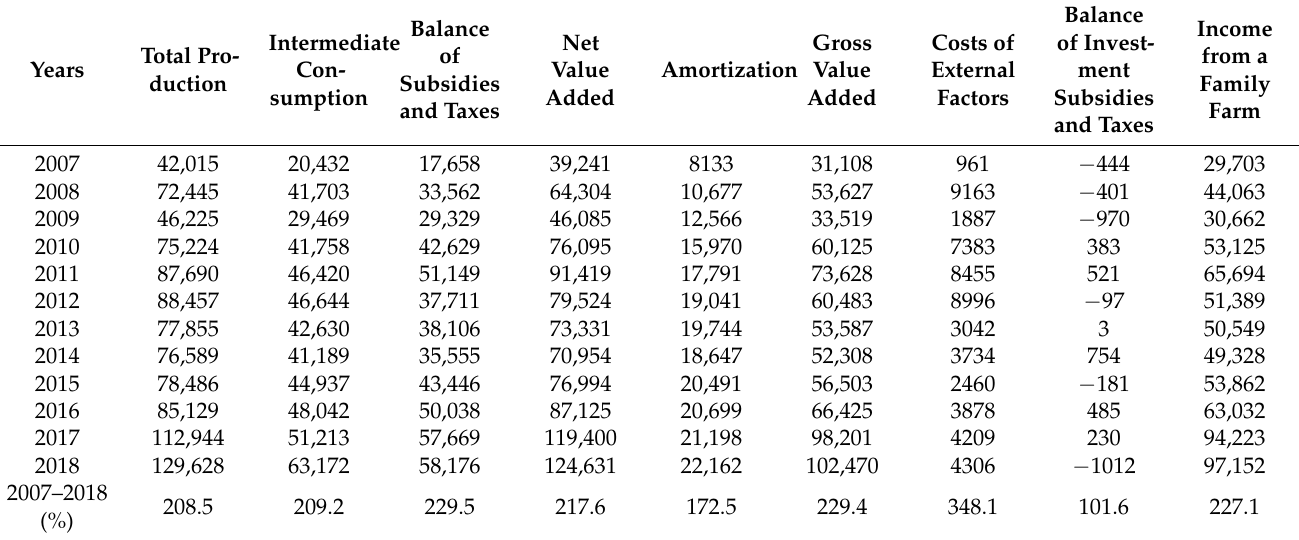
Table 8. Production and income of dairy organic farms in Poland in 2007–2018 (in